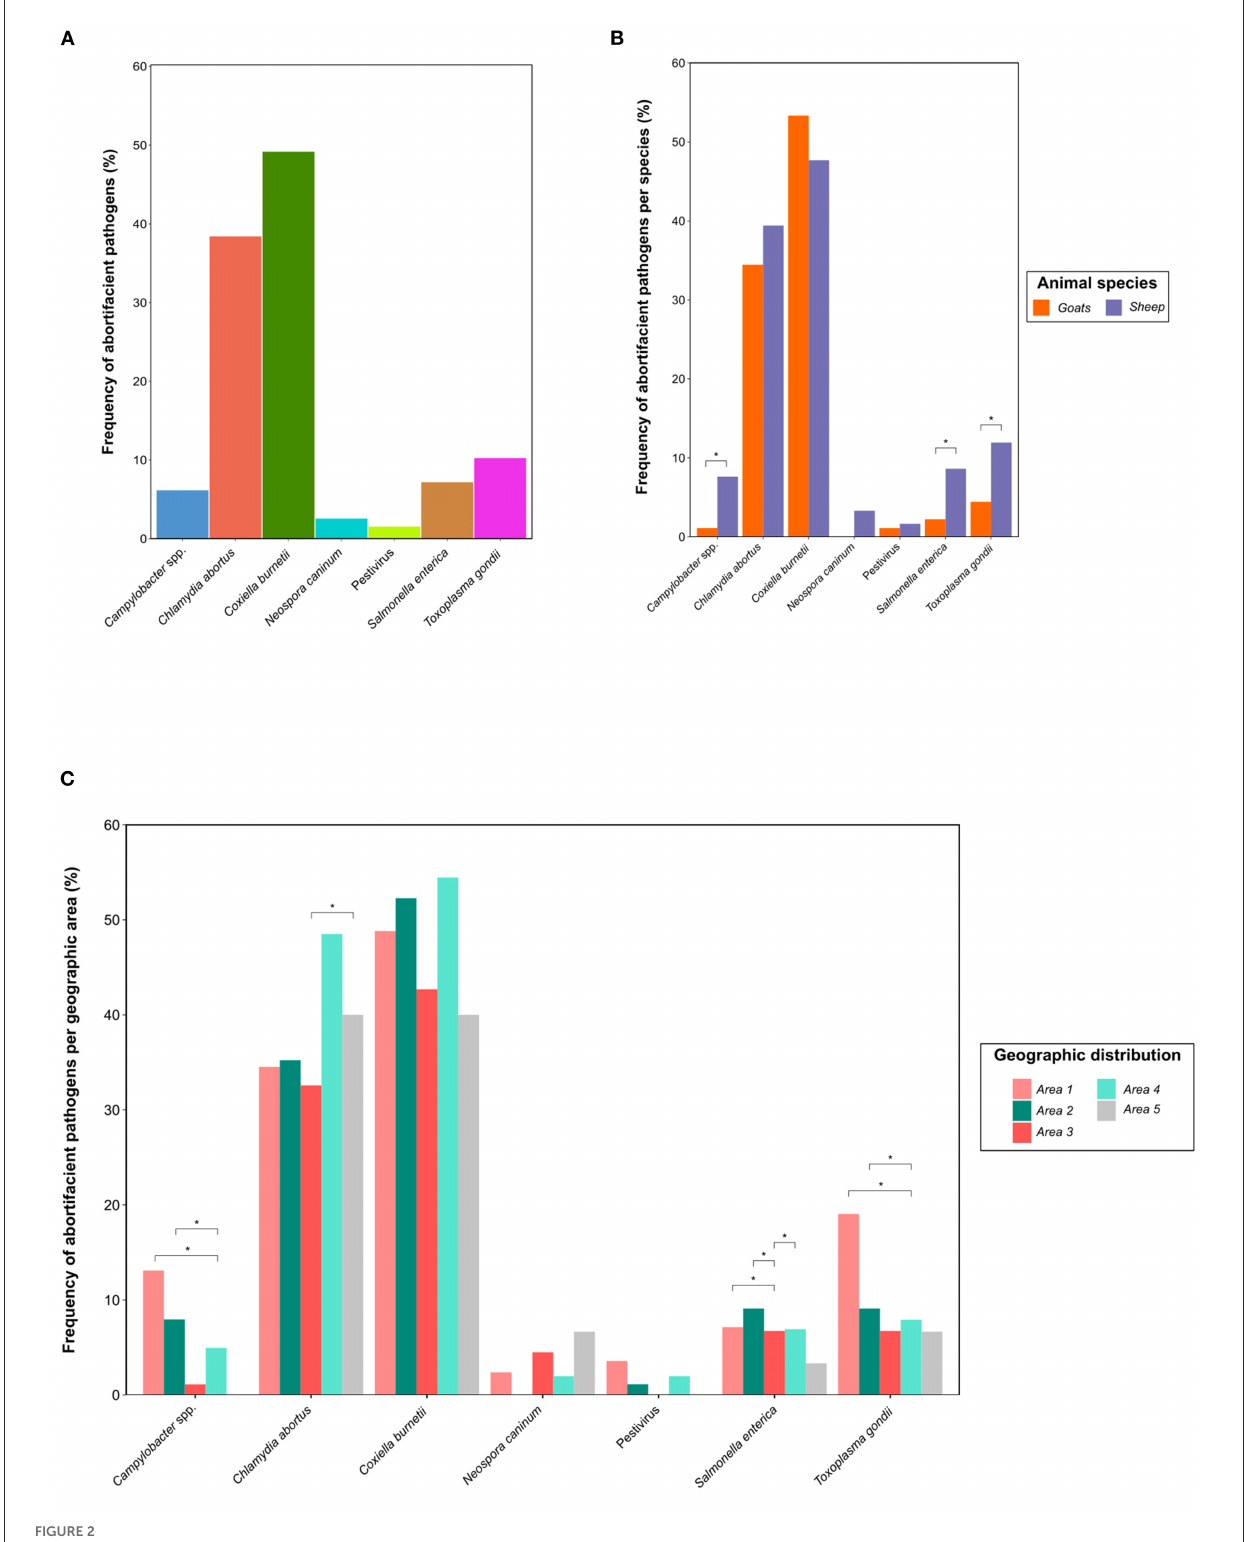
FIGURE2 Distribution of 392 clinical cases of abortions in small domestic ruminants in the Iberian Peninsula referred to the diagnostics laboratory between April 2020 and May 2021 by (A) pathogen; and, within each pathogen by (B) small ruminant species, i.e., sheep (302) and goats (90); and (C) geographic area (Areas 1–5). The differences between sheep and goats and among geographic areas were evaluated by the Fisher’s exact test. The level of statistical significance was represented with asterisks: two asterisks (**) indicated a p -value between 0.001 and 0.01; one asterisk (*) indicated a p -value between 0.01 and